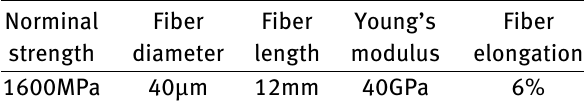
Table 3: Properties of PVA fiber.